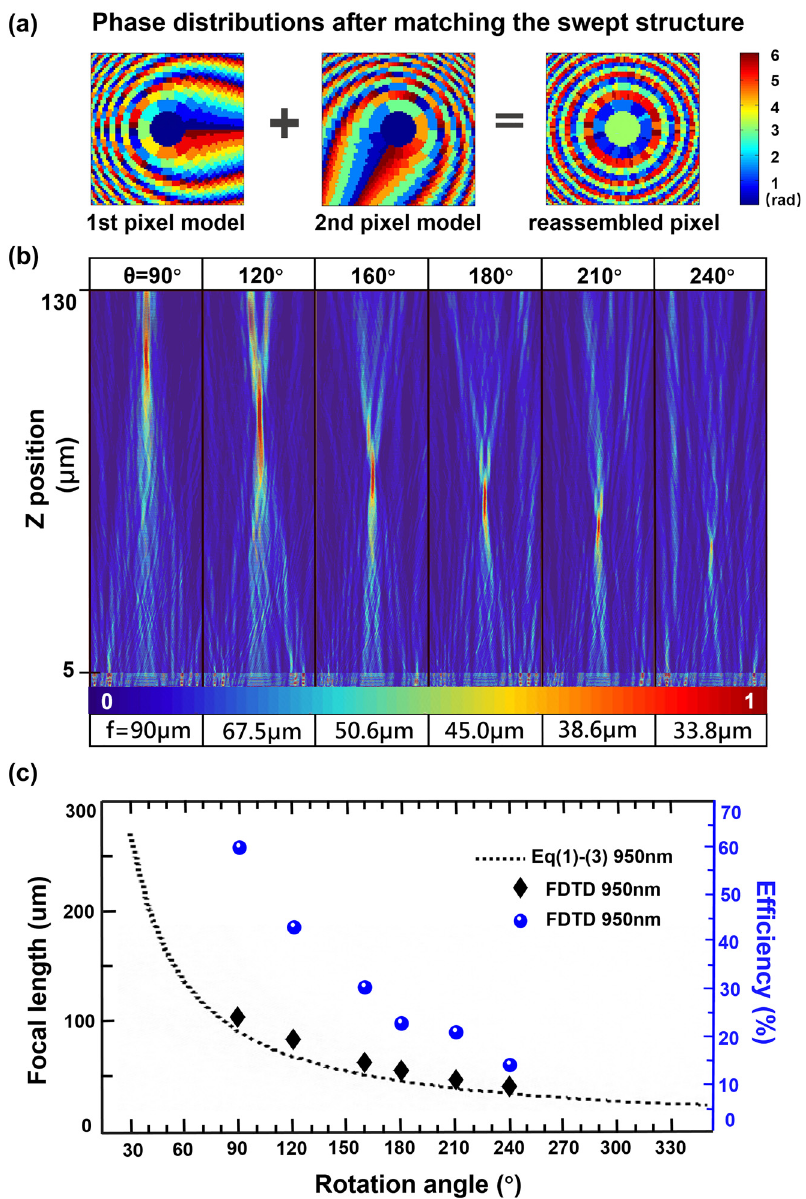
Figure 3: Simulation results of the proposed varifocal metalens. (a) The matched phase distribution. The left image corresponds to the first pixel model/the metasurface layer. The middle image corresponds to the second pixel model/the LC layer. The right image corresponds to the integrated device. (b) Focusing results of the metalens under different relative rotation angle 𝜃 of the Moiré lens ( 𝜃 = 90, 120, 160, 180, 210, 240 ◦ ) at XZ -plane. (c) The comparison graph between the theoretical and simulation results, and the calculated focus